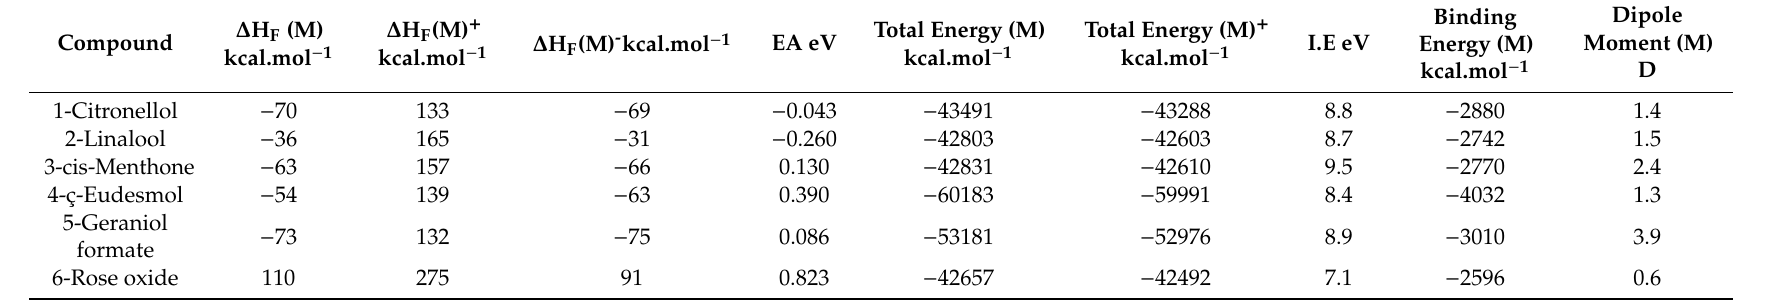
Table 1. Thermodynamic data reported of the studied constituents using MNDO